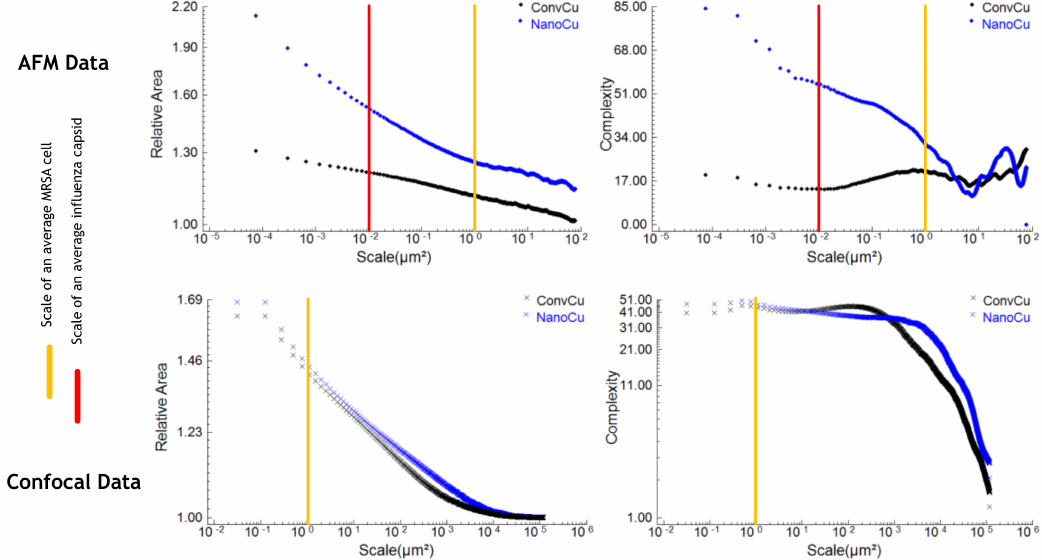
Figure 31. AFM and confocal data for the nanostructured and conventional Cu cold spray